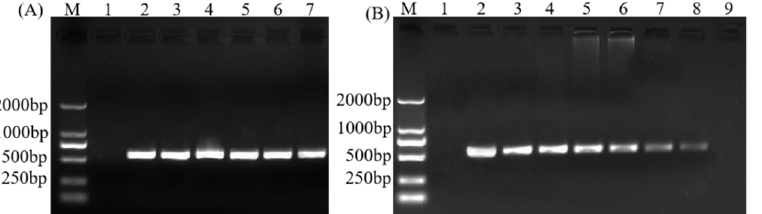
Figure 4. Results of SPLDaP-specific nested PCR using primers R16F2n/R16R2, followed by ASF1/ASR1 with ( A ) different annealing temperatures and ( B ) different template concentrations. ( A ) Lane M: marker DL2000; lane 1: negative control; lanes 2–7: annealing temperature 49 °C, 52 °C, 55 °C, 58 °C, 61 °C, 64 °C, respectively; ( B ) Lane M: marker DL2000; lane 1: negative control; lane 2: positive control; lanes 3–9: DNA dilution 10 0 –10 − 6 (1 ng/ µ L, 100 pg/ µ L, 10 pg/ µ L, 1 pg/ µ L, 100 fg/ µ L, 10 fg/ µ L, 1 fg/ µ L), respectively. Total DNA extraction from SPLDaP-infected sisal as a template for all